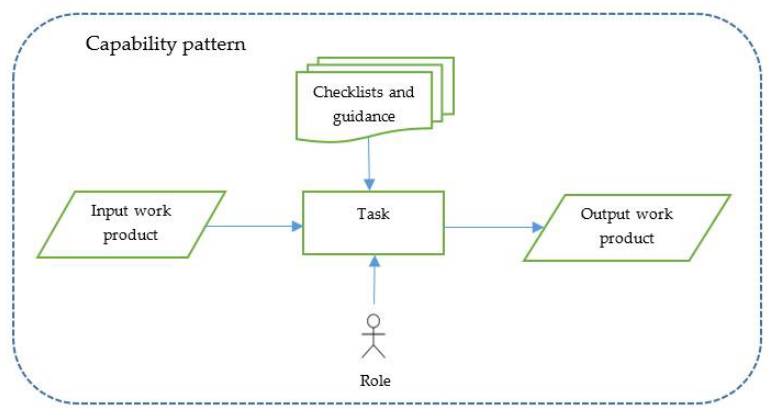
Figure 11. The structure of capability pattern.